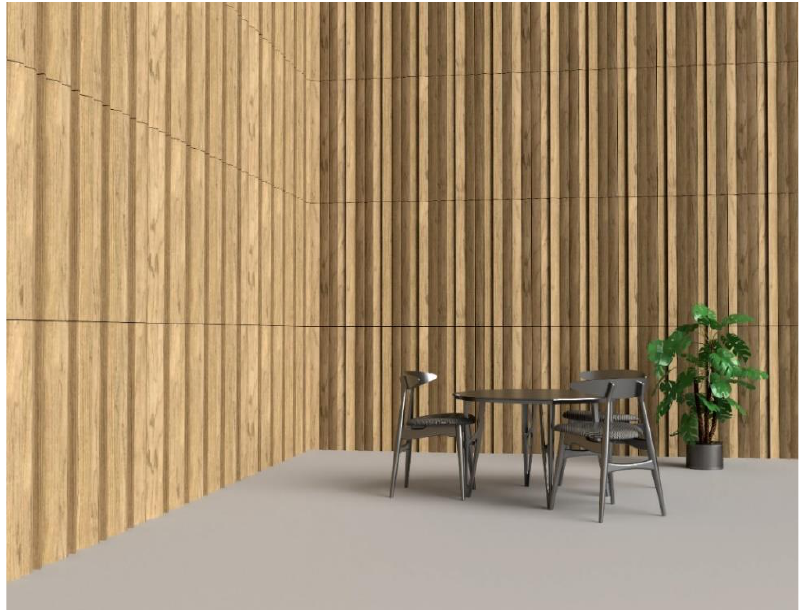
Figure 9. 3D Visualization example of a decorative wooden wall panel created from back board residue (© Domagoj Mamić, 2022).